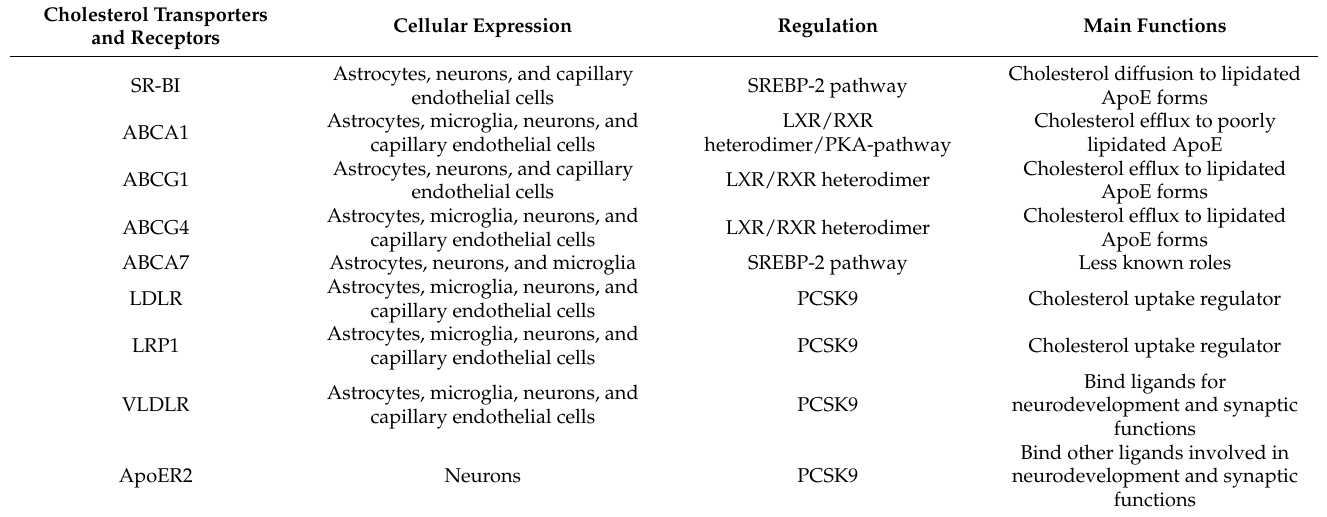
Table 1. Cholesterol transporters and receptors potentially involved in cholesterol efflux and uptake processes in the